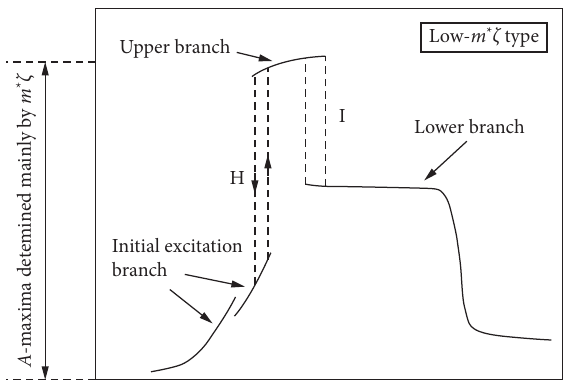
Figure 11: Intermittent switch (I) between upper branch and lower branch.